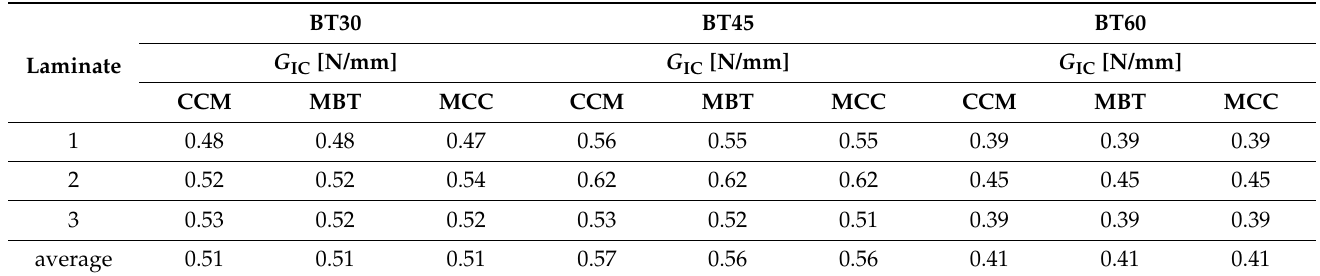
Table 4. Values of critical strain energy release rates determined for bending–twisting coupled laminates by using different data reduction schemes.